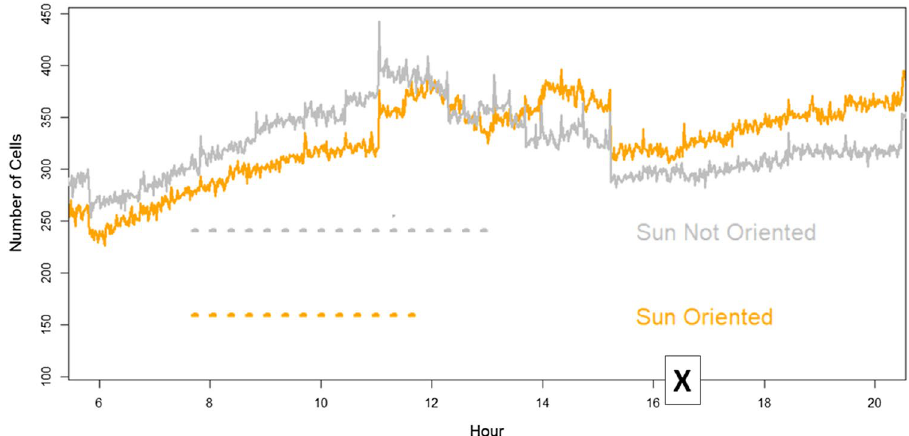
Figure 2. An example of the number cell trend during July 3rd in one (Bologna area, 3702 km 2 ) of six areas involved in the study. “X” indicates the flare peak in X-ray emission (local Italian time, UT + 2H).